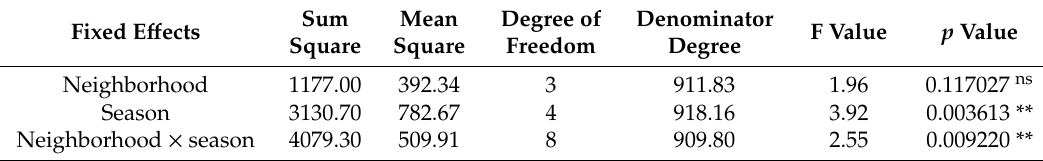
Table 6. ANOVA results for the fixed e ff ects in the linear mixed model.